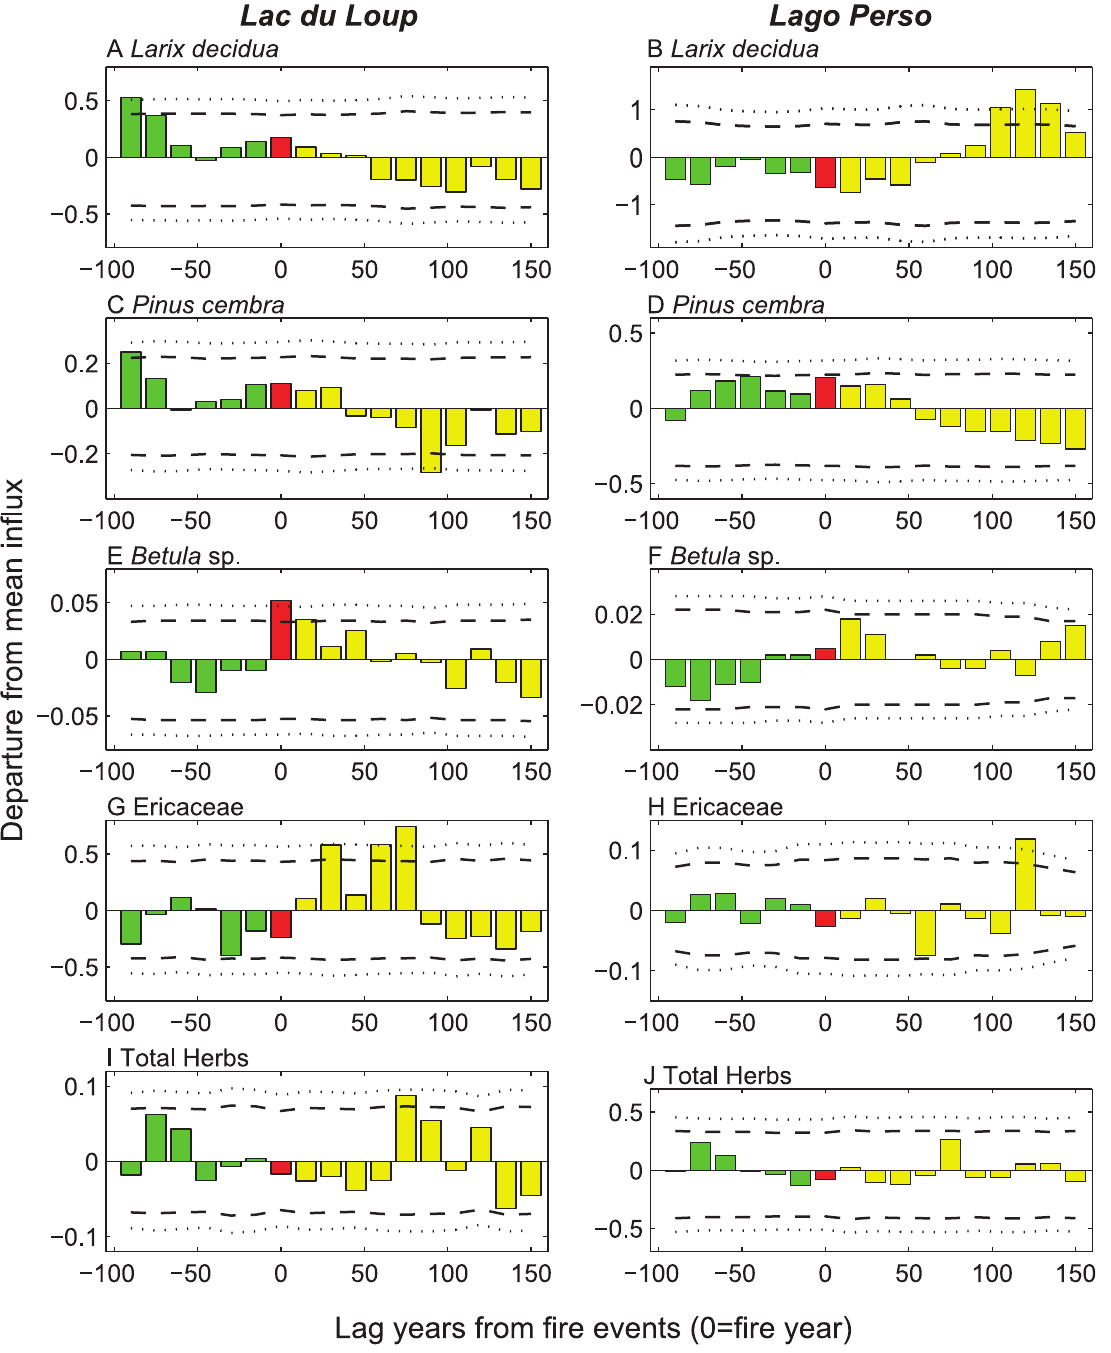
Figure 2. Superposed Epoch Analysis results applied to transformed macroremain influxes of main subalpine species for the two sites. Pre- and post-fire transformed macroremains influx means are colored in green and yellow respectively; fire-year transformed macroremains influx means are in red with 95% and 99% CI of means given as dashed and dotted lines, respectively.